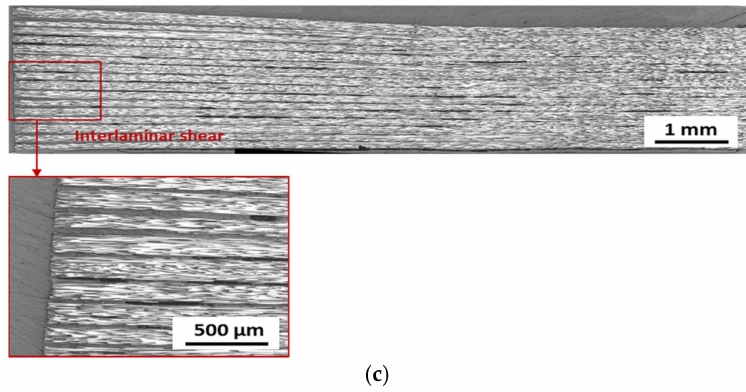
Figure 10. Fracture modes in short-beam shear tests of laminates post-cured for various time: ( a ) unidirectional laminate after post-curing at 180 ◦ C for 2 h; ( b ) cross-ply laminate after post-curing at 180 ◦ C for 2 h; and ( c ) unidirectional laminate after post-curing at 180 ◦ C for 1 h.